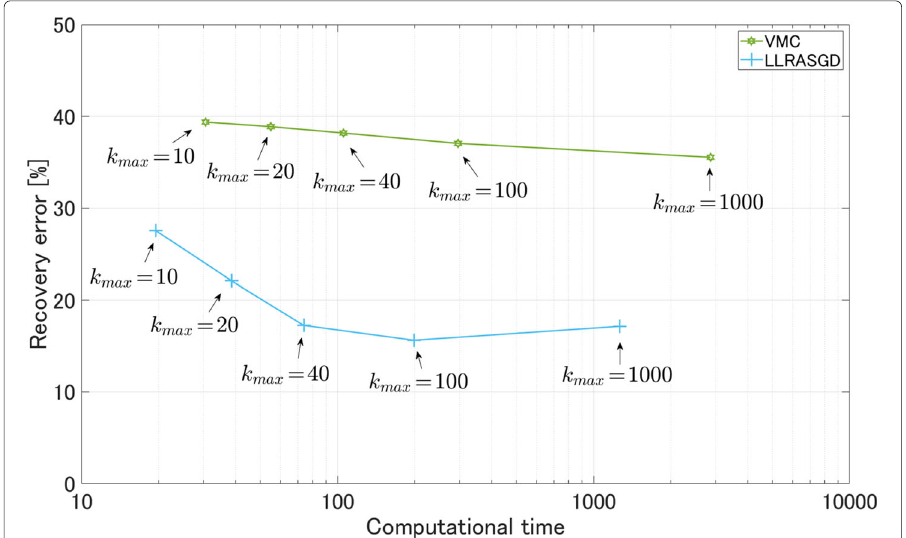
Fig. 6 Computational time [s] vs. recovery error [%] of VMC and LLRASGD for CMU motion capture data recovery ( q =